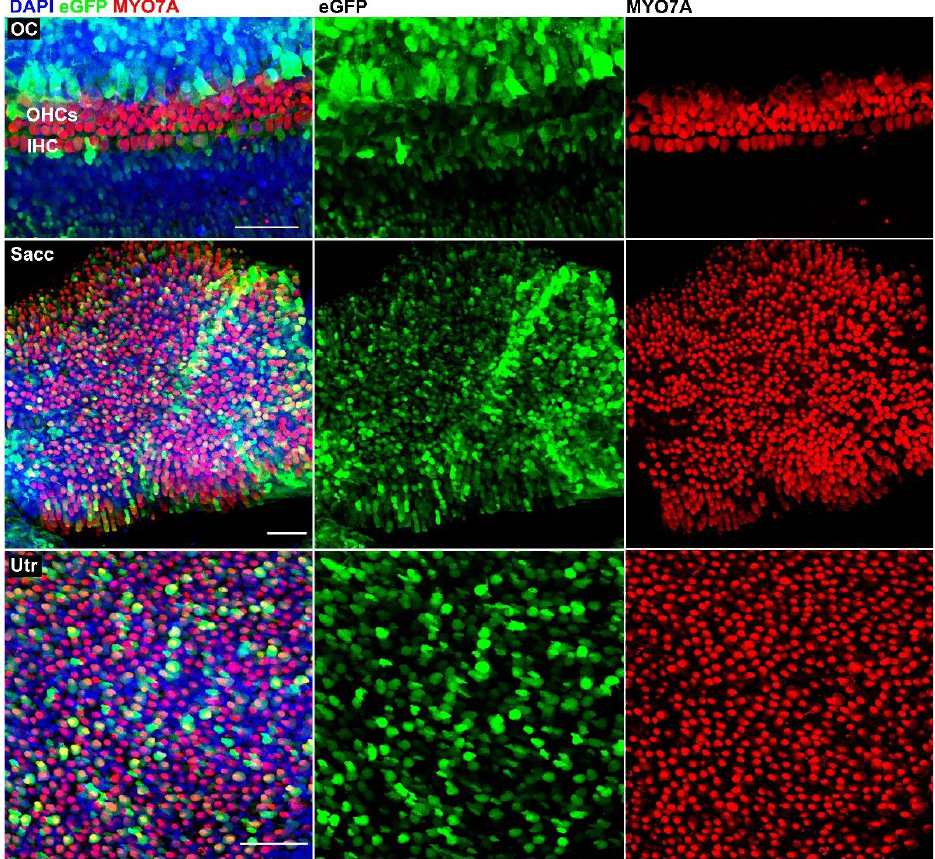
Figure 6. Details of transduced fetal organ of Corti (OC) showing inner and outer hair cells, respec- tively (IHC, OHC), and a fetal saccule (Sacc) and utricle (Utr), immunostained with anti-MYO7A antibodies. Fetal age = 14 weeks. Scale bars apply to all images in each row: 50 µm.